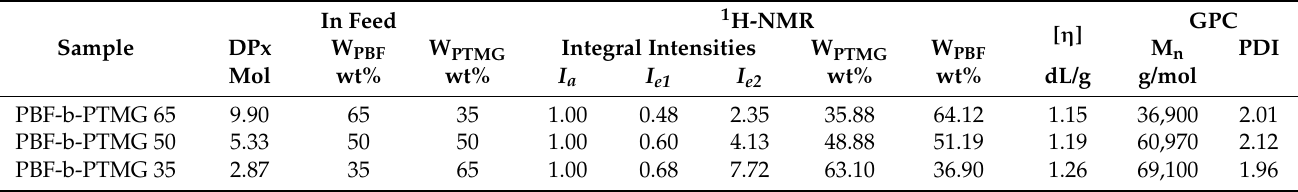
Table 1. The chemical composition and molecular weights of PBF- b- PTMG copolymers.